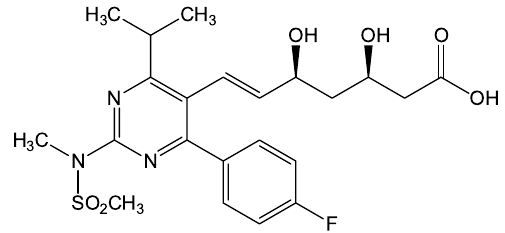
FIGURE 1 - Molecular structure of